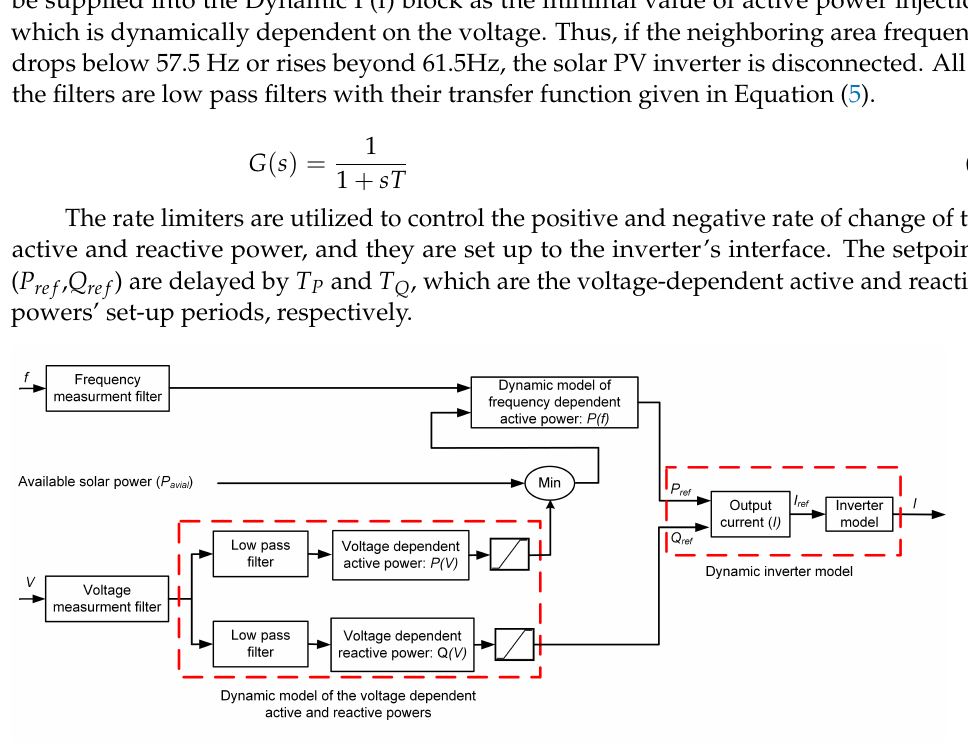
Figure 4. Phasor model of the on-grid solar